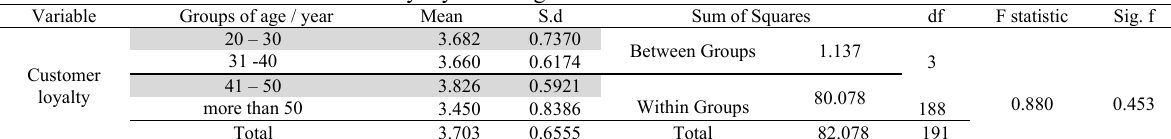
ANOVA test for differences in customer loyalty due to age